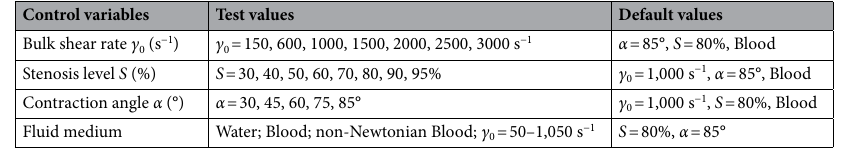
Table 3. Control variable